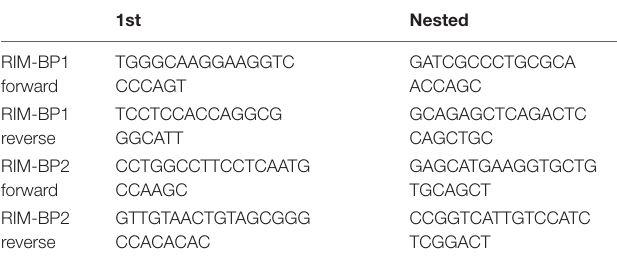
TABLE 1 | Primers for nested